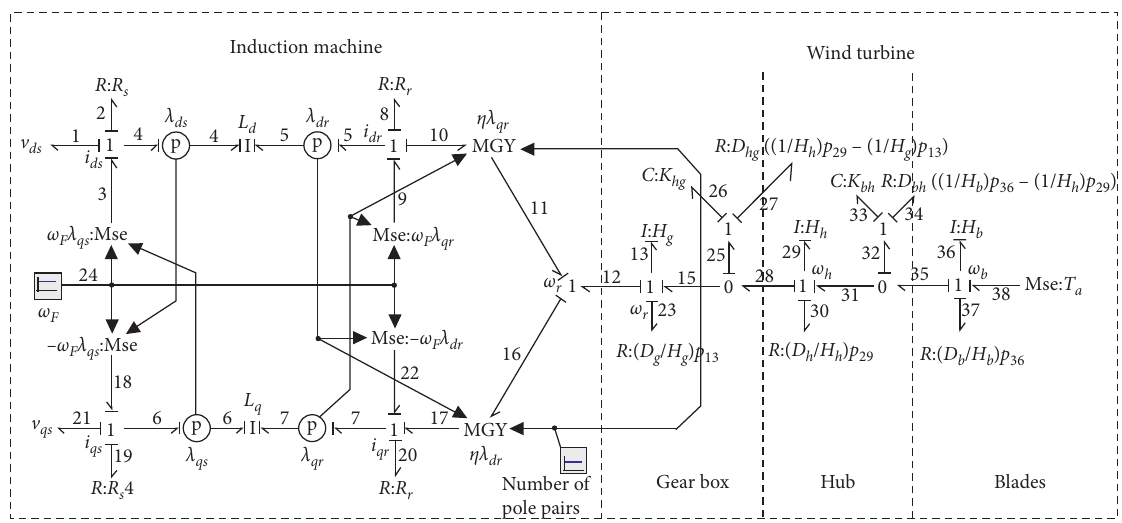
Figure 7: Bond graph in an integral causality assignment of the wind